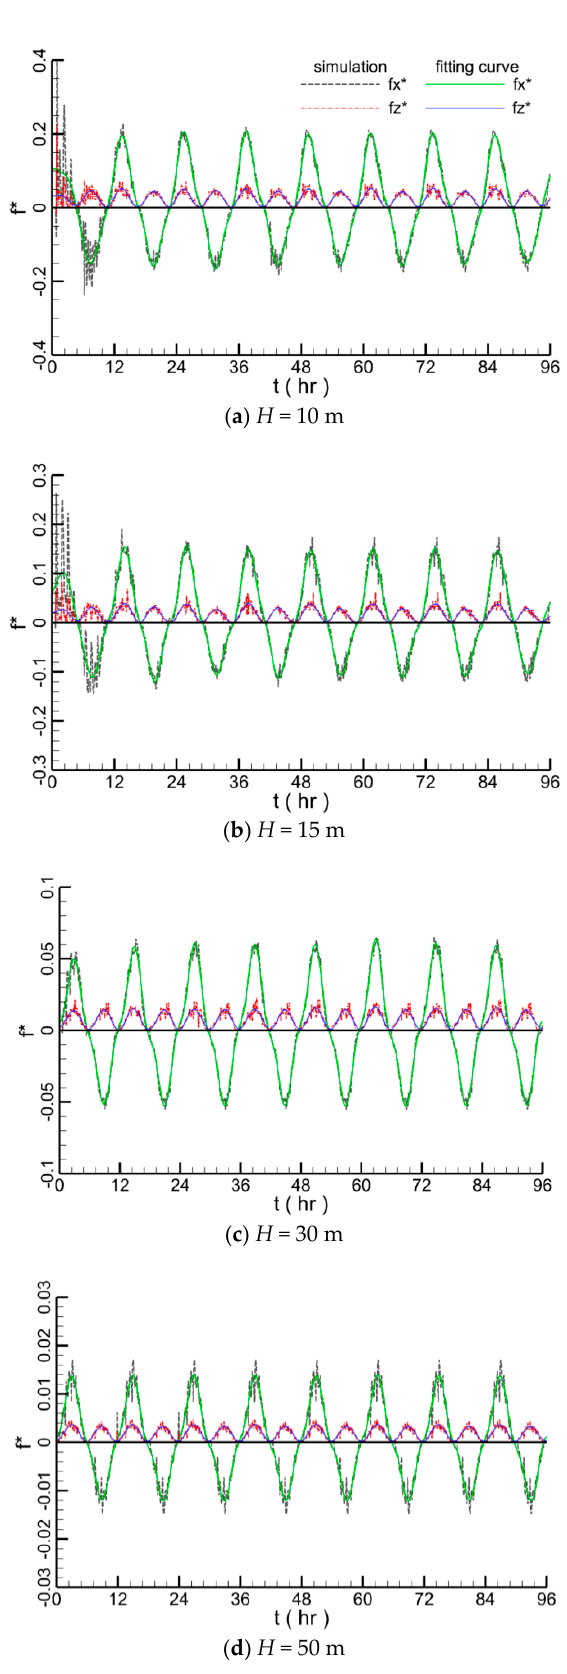
Figure 20. The hydrodynamic force on pipeline with different water depths.